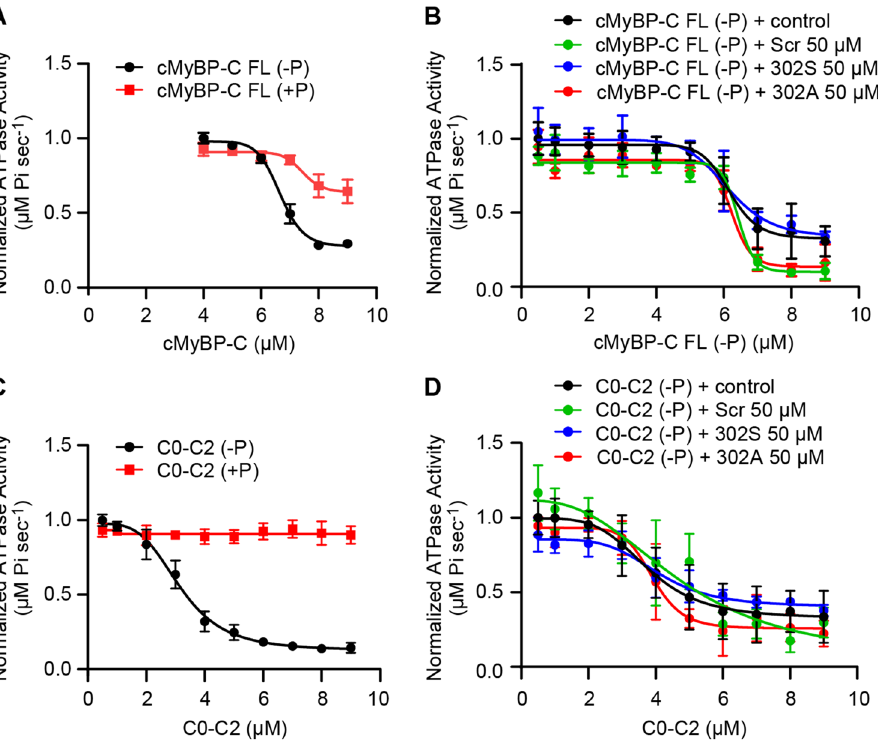
Figure 3. cMyBP-C peptides have no effect on steady-state ATPase assay with truncated cMyBP-C C0C2 or FL cMyBP-C. ( A ) Dephosphorylated FL cMyBP-C inhibited myosin ATPase activity more than inhibition of myosin by phosphorylated cMyBP-C. ( B ) cMyBP-C 302A or 302S peptides had no effect on myosin ATPase FL cMyBP-C activity. ( C ) Dephosphorylated cMyBP-C C0-C2 inhibited myosin ATPase activity, but not phosphorylated cMyBP-C. ( D ) cMyBP-C peptides 302A or 302S had no effect on CO-C2 myosin ATPase activity. Data represent mean ± SEM (N = 4–12). FL, full-length. Scr,